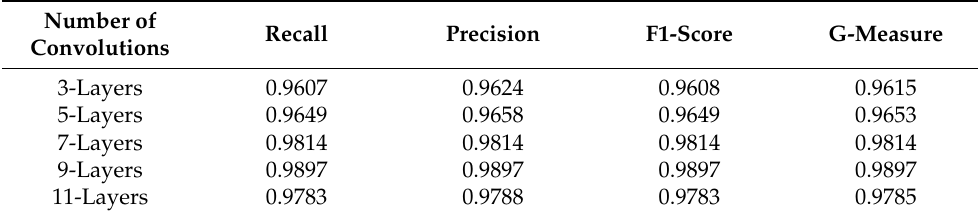
Table 9. Comparison of CNN models with various convolution layers.